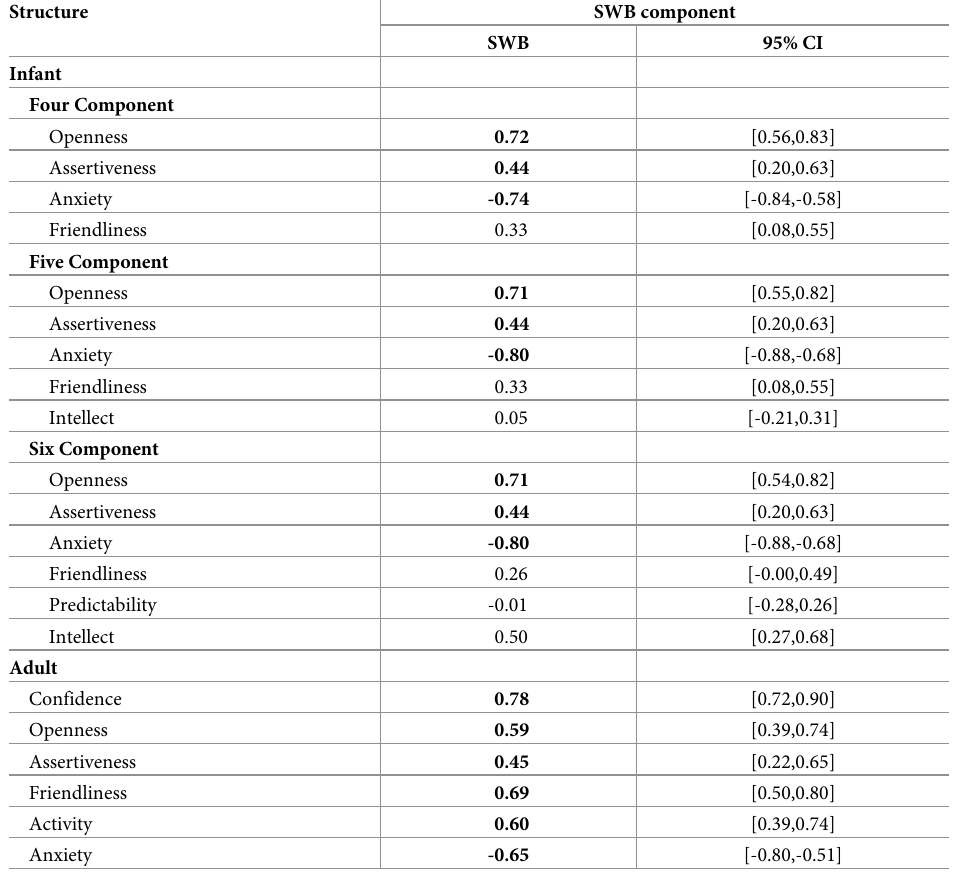
Table 4. Pearson correlation of subjective well-being and infant and adult personality structures. Structure